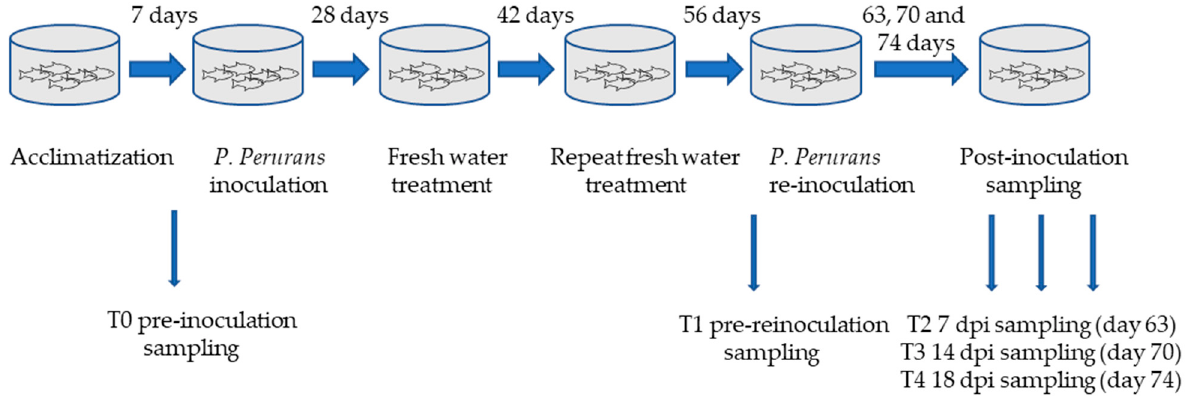
Figure 1. Experimental design of trial investigating the host response to repeat infection with P. perurans. Fish were acclimatized for 7 days. Immediately prior to the initial P. perurans inoculation, naïve control fish were sampled (T0). AGD was confirmed by gill score analysis 21 days after inoculation and fish were treated by freshwater immersion. Some features of AGD persisted 14 days after freshwater treatment, and the freshwater immersion was repeated. Fish health was confirmed by gross gill analysis 14 days after the second freshwater treatment, and fish were sampled prior to re-infection with P. perurans (T1). Fish were sampled at 7 (T2), 14 (T3) and 18 (T4) days post re-infection.